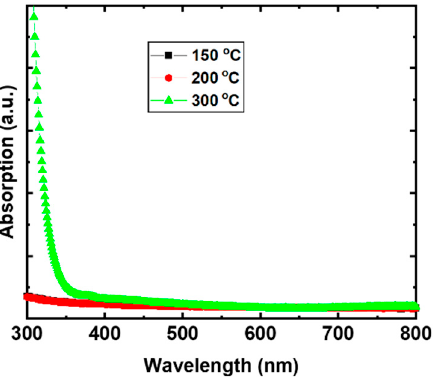
Figure 7. AFM images of Cu:NiO x films fabricated on quartz substrates from precursor containing 0.1 molar ratio of fuel (Acac) to oxidizer (Cu, Ni nitrates) annealed at ( a ) 150 and ( b ) 300 °C. The UV ‐ vis absorption spectrum (Figure 8) of the films treated at 150 and 200 °C show no prominent absorption due to the amorphous nature of metal oxides, while, for 300 °C annealing film, the absorption onset at ~400 nm (~3.1 eV) and strong absorption at ~350 nm (~3.5 eV) is ascribed to the crystalline Cu:NiO x phase.